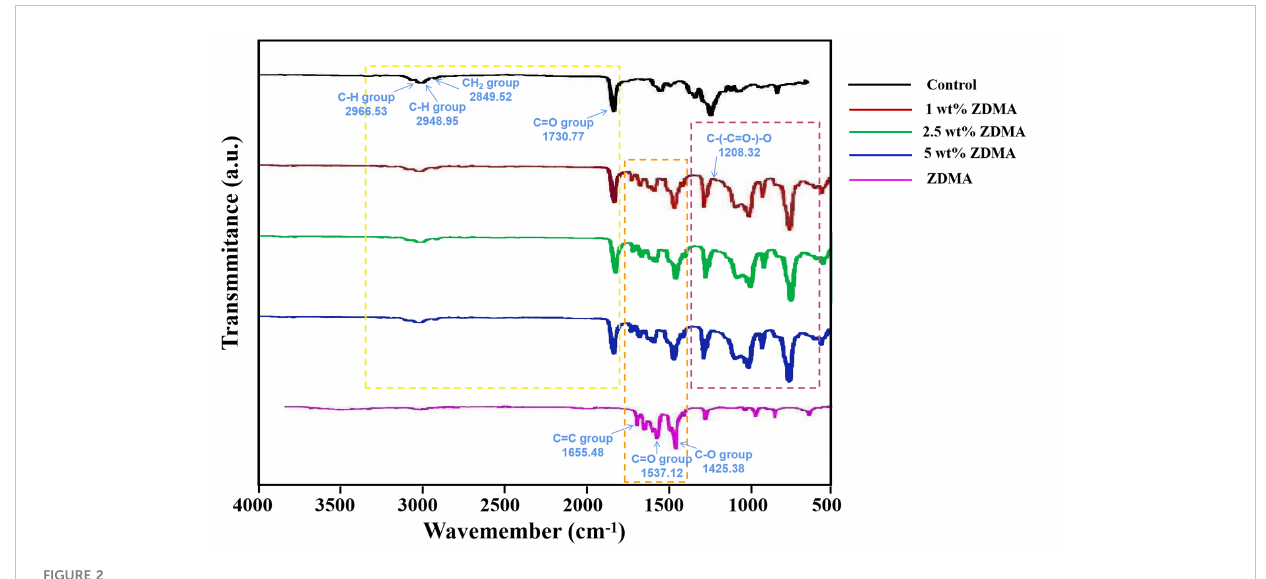
FIGURE 2 FTIR spectra of unmodi fi ed PMMA, ZDMA modi fi ed PMMA and